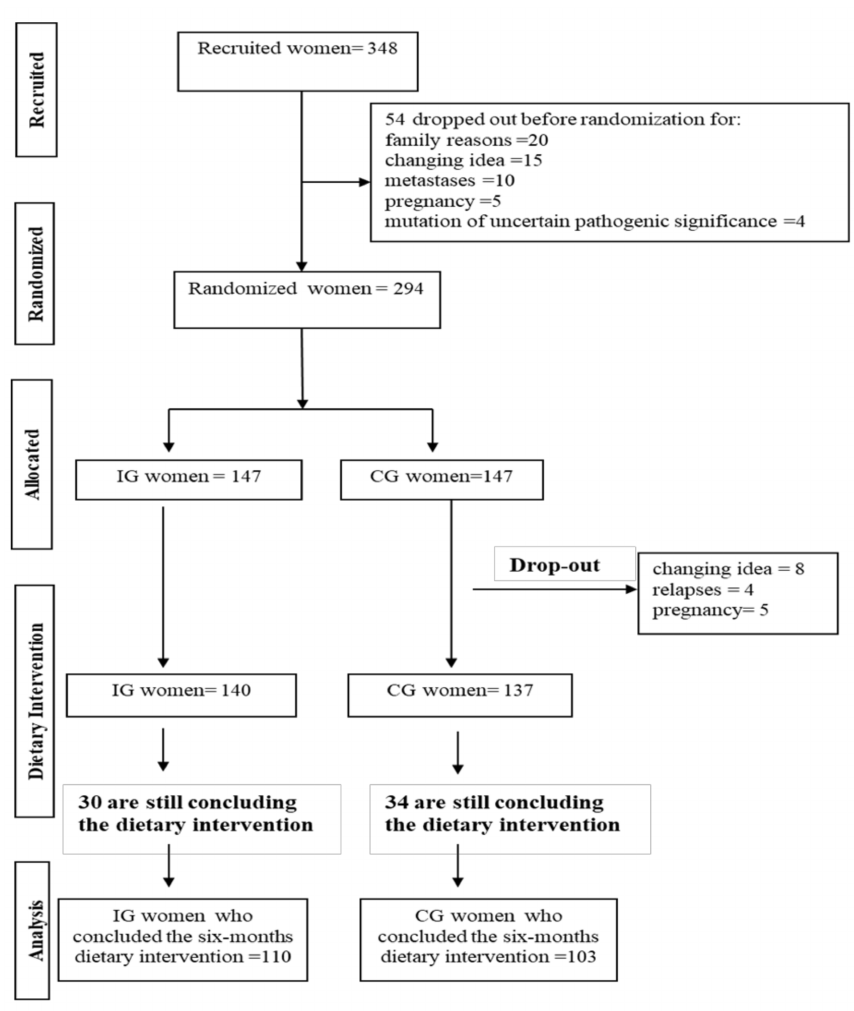
Figure 1. Flowchart of the trial. IG: Intervention Group; CG: Control